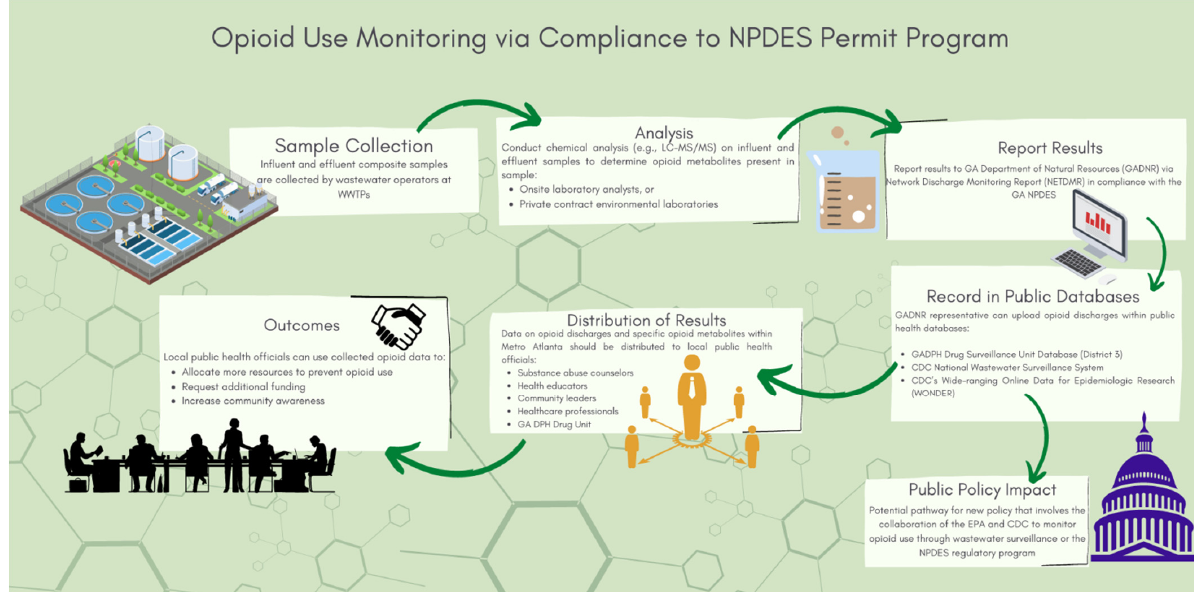
Figure 2. Streamlined approach on opioid use monitoring through compliance to the NPDES permit program.